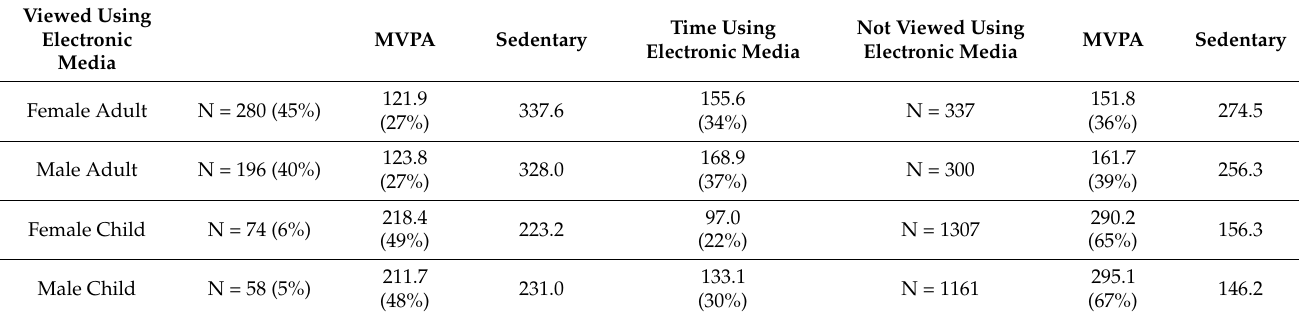
Table 3. Percentage of electronic media users and time viewed using electronic media.